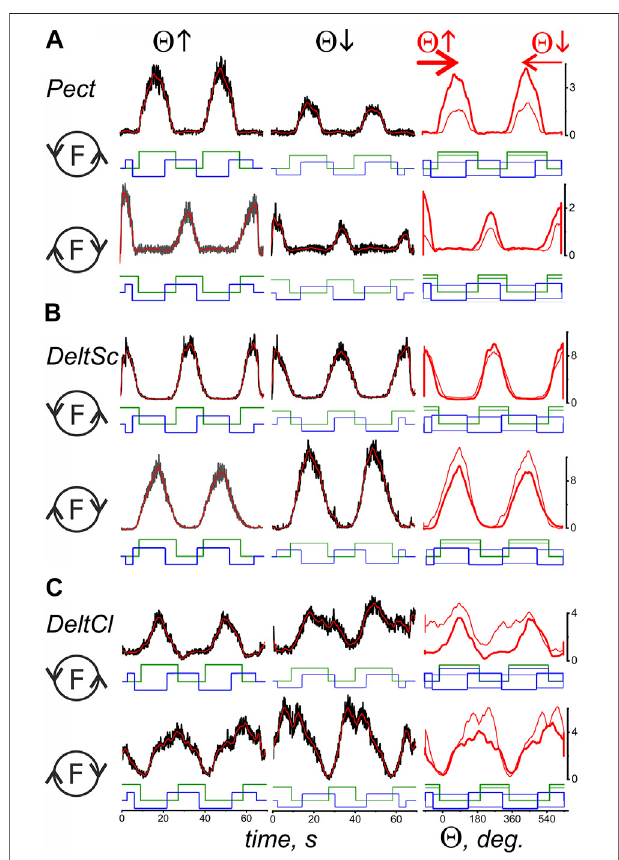
FIGURE 4| Comparison of theaveraged EMG activitiesin the fl exor and extensor muscles of the shoulder joint during test movements. The data were obtained in the same experiment as in Figure 3 ; combining both drawings proved impractical due to their scope. The structure of the plots and all the designations (except for the names of muscles) are the same as in Figure 3